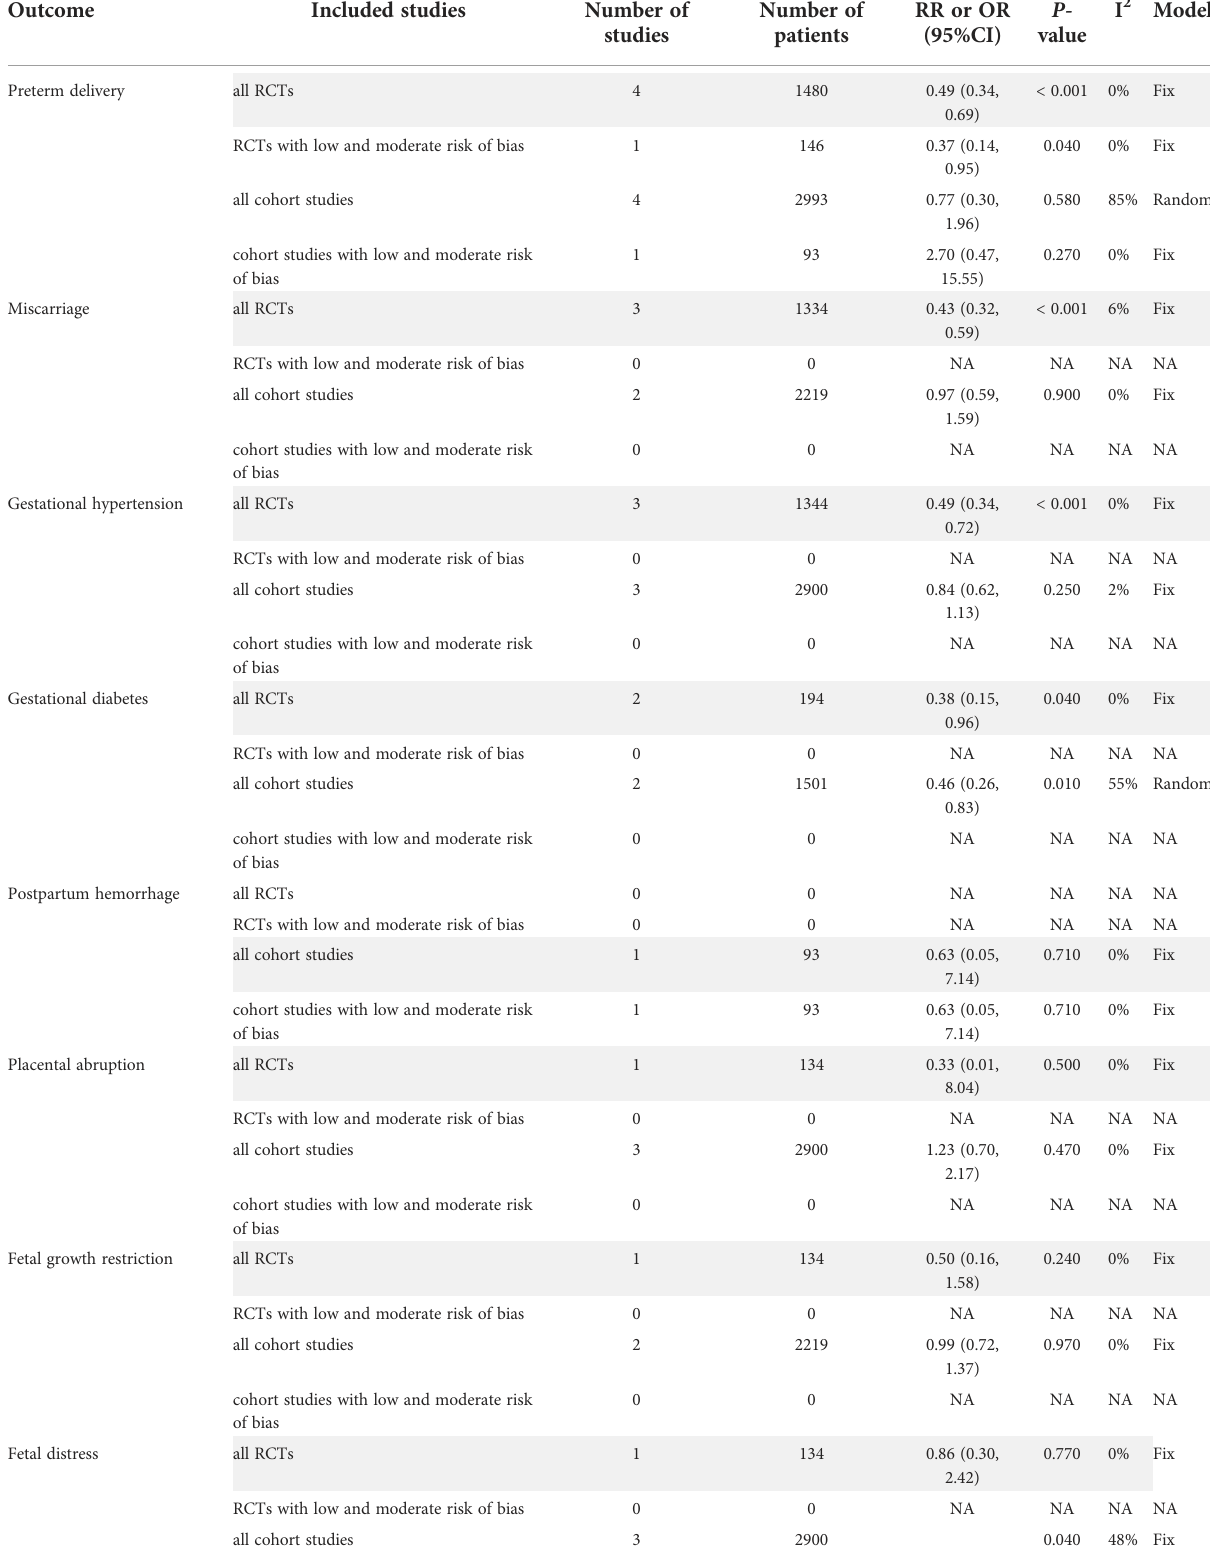
TABLE 3 Meta-analysis results of the TPOAb-negative